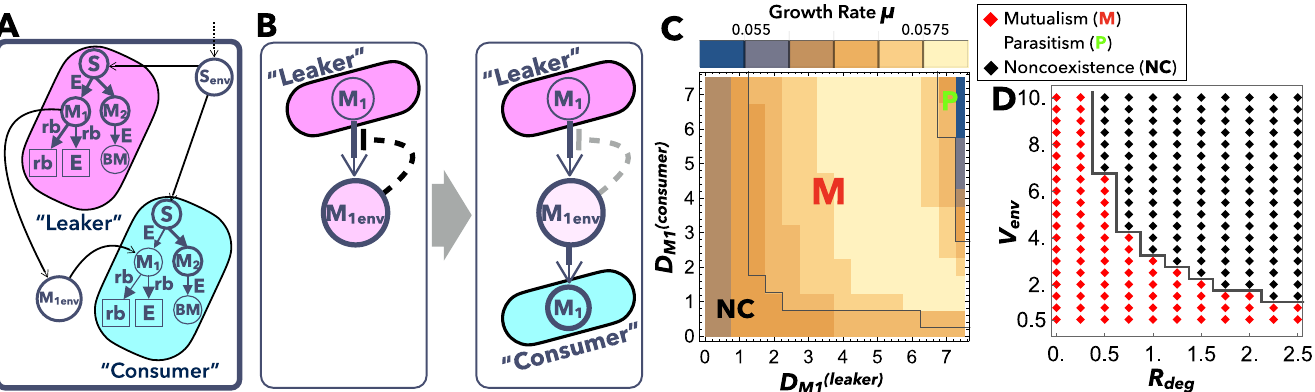
Fig 2. Example of leaker-consumer mutualism between two cell species. (A) A simple example of the mutualism between the leaker (left) and consumer (right) cells. Both have the same network structure that consists of substrate S , enzyme E , ribosome rb, metabolites M 1 and M 2 , and biomass BM, with different rate constants. (B) Schematic illustration of leaker-consumer mutualism. When only a leaker cell is present, the secreted chemical accumulates in the environment and inhibits further secretion (left). The coexistence of other consumer cells is beneficial for both cells as it reduces the concentration of the leaked chemical in the environment (right). (C) Phase diagram of symbiosis depending on D ð leaker Þ and D ð consumer Þ . Regions M (red), P (green), and NC (black) are delineated by gray lines and represent mutualism, M 1 M 1 parasitism, and noncoexistence, respectively. The environment volume ratio V env and the degradation rate in the environment R deg are both set at unity. The color ¼ 0 is just the growth rate of the leaker cells in isolated conditions, m ð leaker Þ denotes the growth rate μ , where a brighter color corresponds to a higher μ . μ with D ð consumer Þ M 1 region M, it is smaller than μ at the corresponding D ð leaker Þ value in the panel. (D) Phase diagram of symbiosis depending on the environmental parameters, R deg and V env . M 1 ¼ D ð consumer Þ ¼ 4 . Red and black diamonds are delineated by gray lines and represent mutualism and noncoexistence, The diffusion coefficients of M 1 are fixed as D ð leaker Þ M 1 M 1 respectively. The rate constants are set as: k ð leaker Þ ¼ 1 ; k ð consumer Þ ¼ 0 : 4 ; k ð leaker Þ ¼ k ð leaker Þ ¼ k ð leaker Þ ¼ 1 ; k ð consumer Þ S ! M 1 S ! M 1 M 1 ! rb M 1 ! E S ! M 2 M 1 ! rb so that the leaker’s growth rate in isolation m ð leaker Þ with optimal diffusion coefficient D ð leaker Þ is higher than the consumer’s growth rate in isolation m ð consumer Þ iso M 1 ¼ 0 . The other parameters are set as S ¼ 1 : 0 ; D ð env Þ ¼ 10 : 0 ; D ¼ 1 : 0 D ð consumer Þ M S env S 1